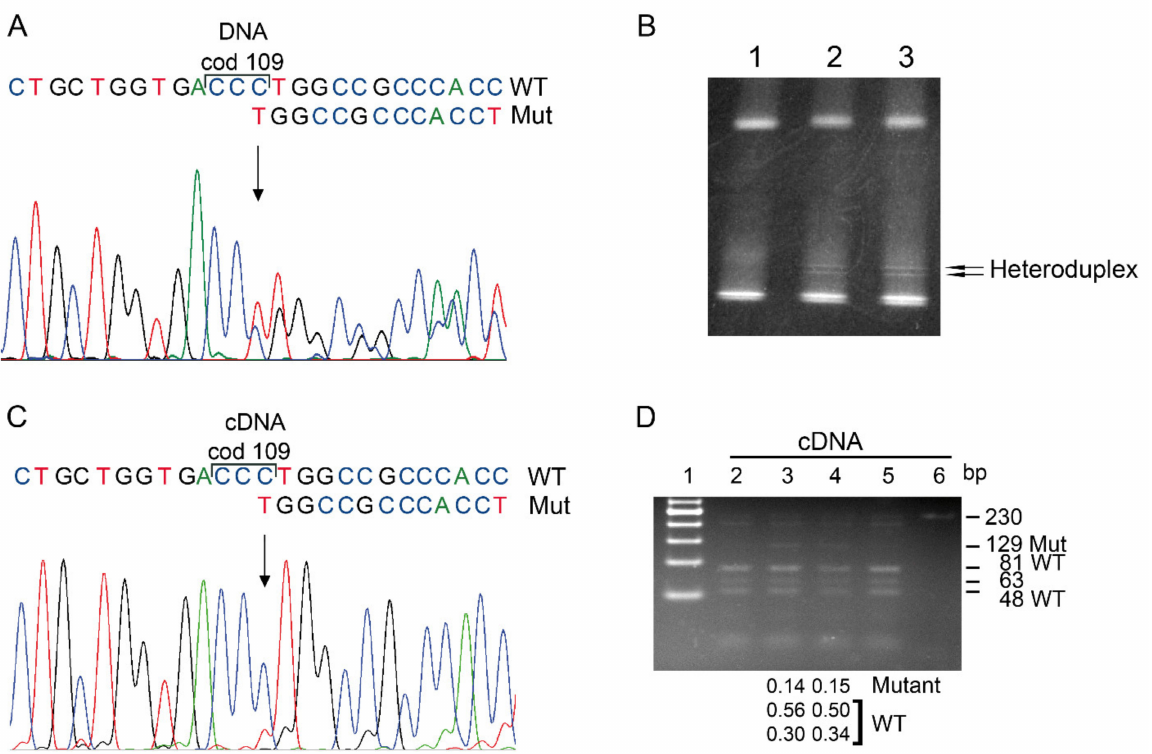
Figure 5. Molecular characterization and cDNA analysis of Hb Sciacca . ( A ) α 1-globin gDNA sequence of an Hb Sciacca carrier. ( B ) Denaturing gradient gel electrophoresis (DGGE) of amplicomer III of the α -globin genes containing codon 109. Lane 1: subject with WT α 1-globin; Lanes 2 and 3: Hb Sciacca heterozygotes. ( C ) α 1-globin cDNA sequence of an Hb Sciacca carrier. ( D ) The cDNA amplicomers of 230 bp, digested with the restriction enzyme BseDI and separated on a 3.5% NuSieve 3:1 agarose gel. Lane 1: 50 bp ladder; Lanes 2 and 5: cDNA of subjects with WT α 1-globin; Lanes 3 and 4: cDNA of the Hb Sciacca heterozygotes; Lane 6: undigested cDNA sample. The Hb Sciacca eliminates the BseDI restriction site C’CCTGG, generating an anomalous longer cDNA band of 129 bp, corresponding to the sum of the two WT-specific bands of 81 and 48 bp, minus the deleted cytidine base. The fragments’ lengths are reported on the right. The relative quantities of longer abnormal bands and WT bands are reported in the lower